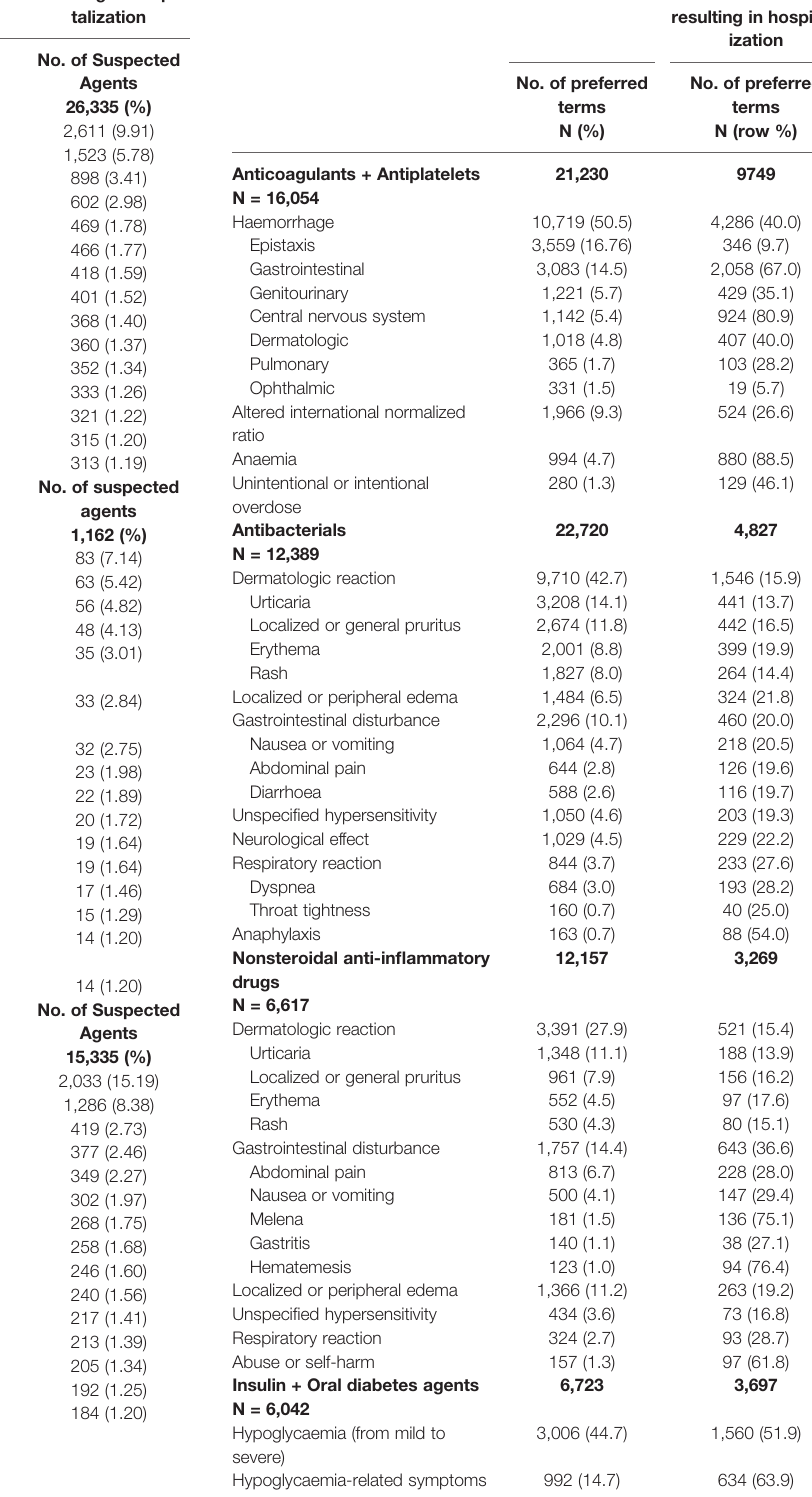
TABLE 3 | Most commonly reported suspected drug products by patient